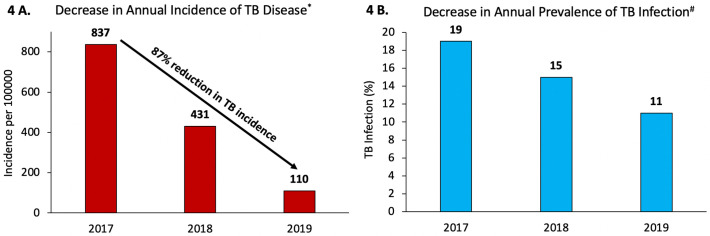
Decline in tuberculosis (TB) burden in children and adolescents in the Tibetan boarding schools in India from 2017 through 2019.(A) Decrease in annual incidence of TB disease. (B) Decrease in annual prevalence of TB infection. *Incidence of annual TB disease represents the proportion of new episodes of TB cases per 100,000 students per year among all students enrolled in the schools (Table 5). #Prevalence of annual TB infection represents the proportion of students testing positive for tuberculin skin test per year among all students at the schools who were not tested previously or had tested negative previously.